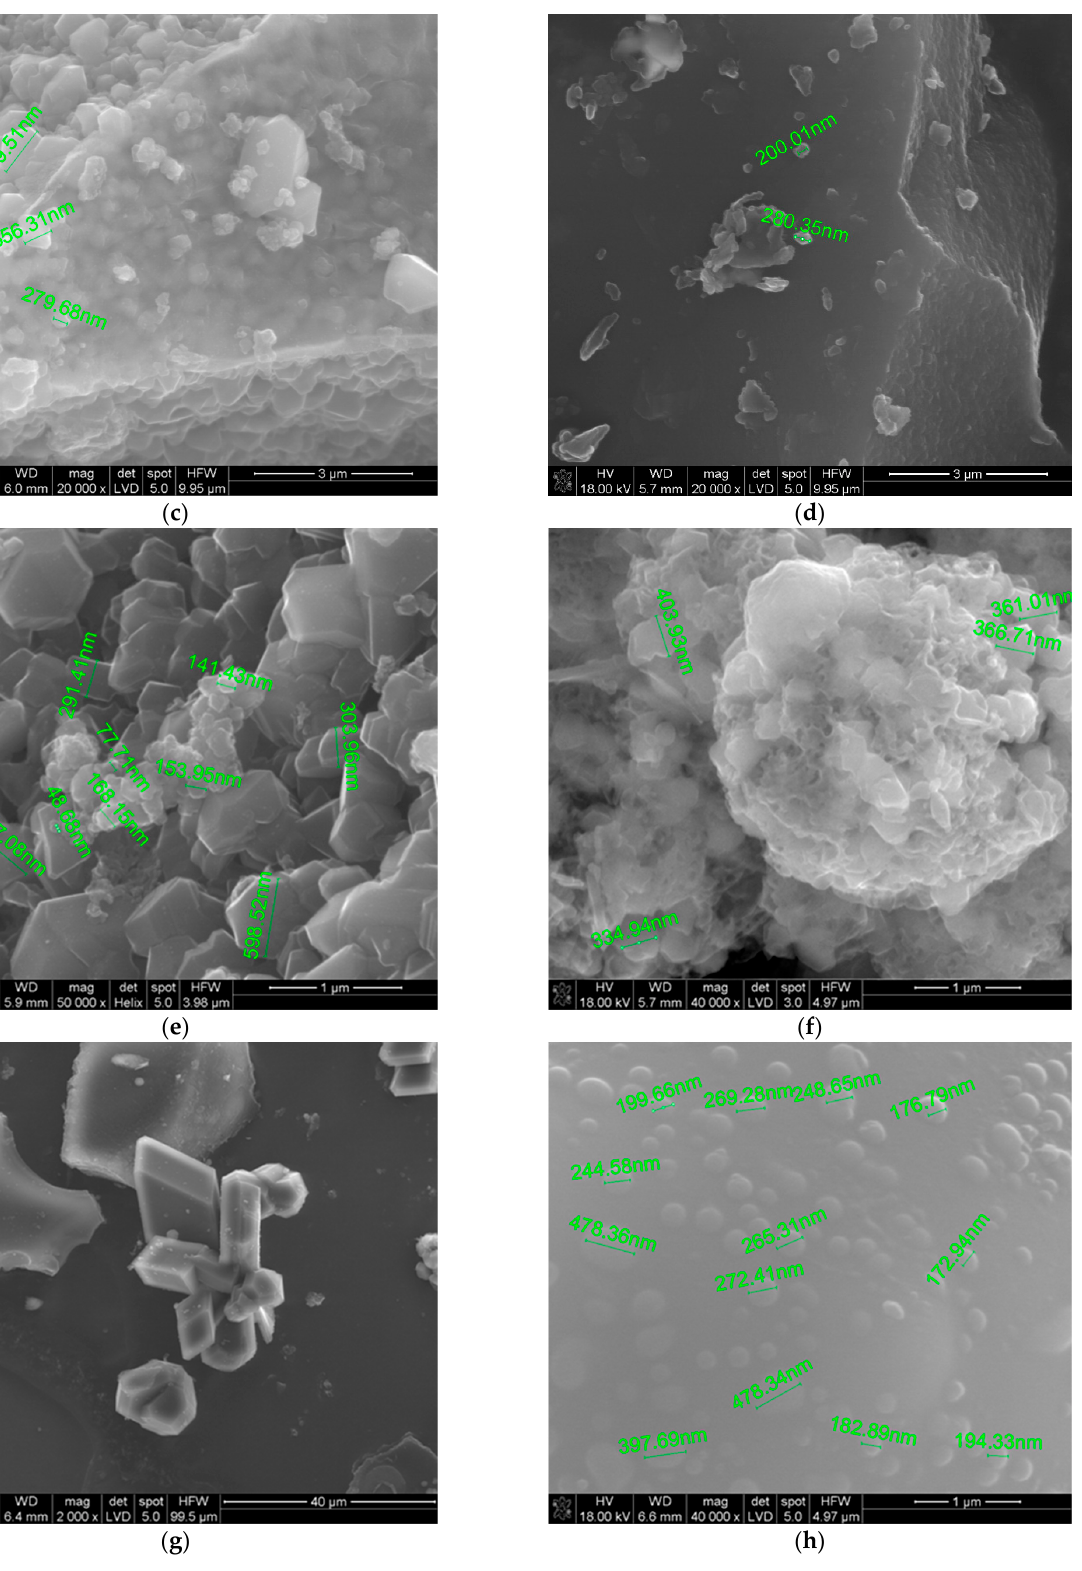
Figure 10. SEM images of the boron carbide obtained from powders prepared at the same temperature using saccharides: ( a ) glucose, ( b ) freeze-drying glucose, ( c ) fructose, ( d ) freeze-drying fructose, ( e ) dextrin, ( f ) freeze-drying dextrin, ( g ) HES, and ( h ) freeze-drying HES [16].